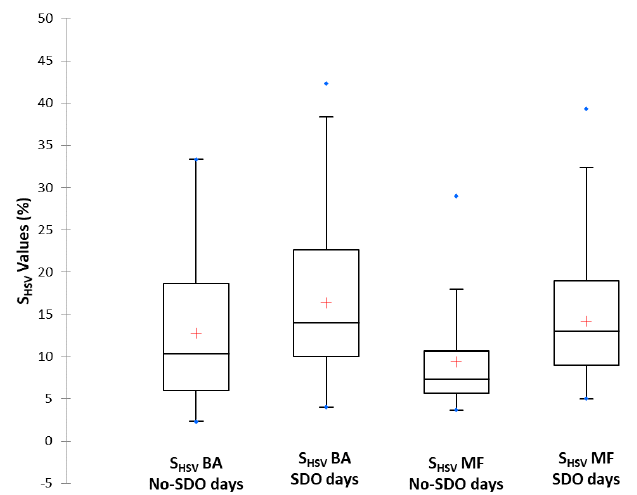
Figure 11. Box-plot of S HSV values obtained to compare values for No-SDO days versus SDO days from Badajoz and Monfragüe monitoring stations.